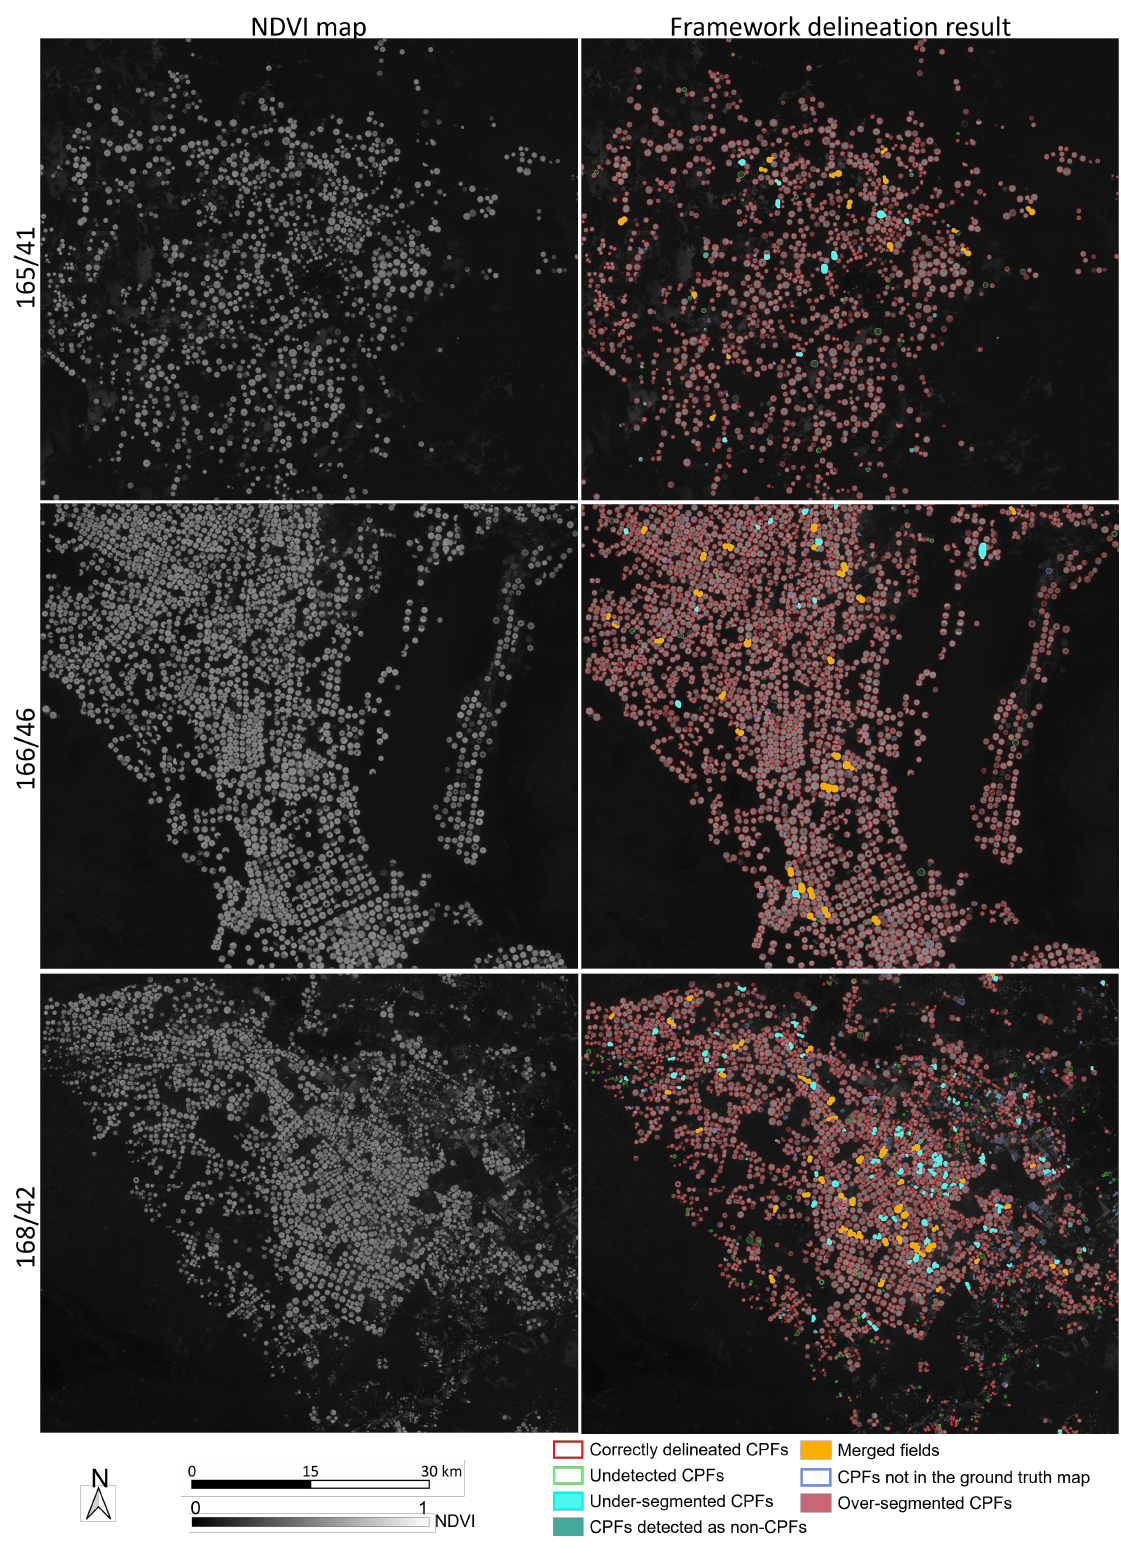
Figure 3. Maximum annual NDVI maps (framework input) and associated center-pivot field (CPF) delineation results for the three evaluation tiles (paths/rows 165/41, 166/46, and 168/42) in 2015. Non-CPFs indicated fields showing rectangle